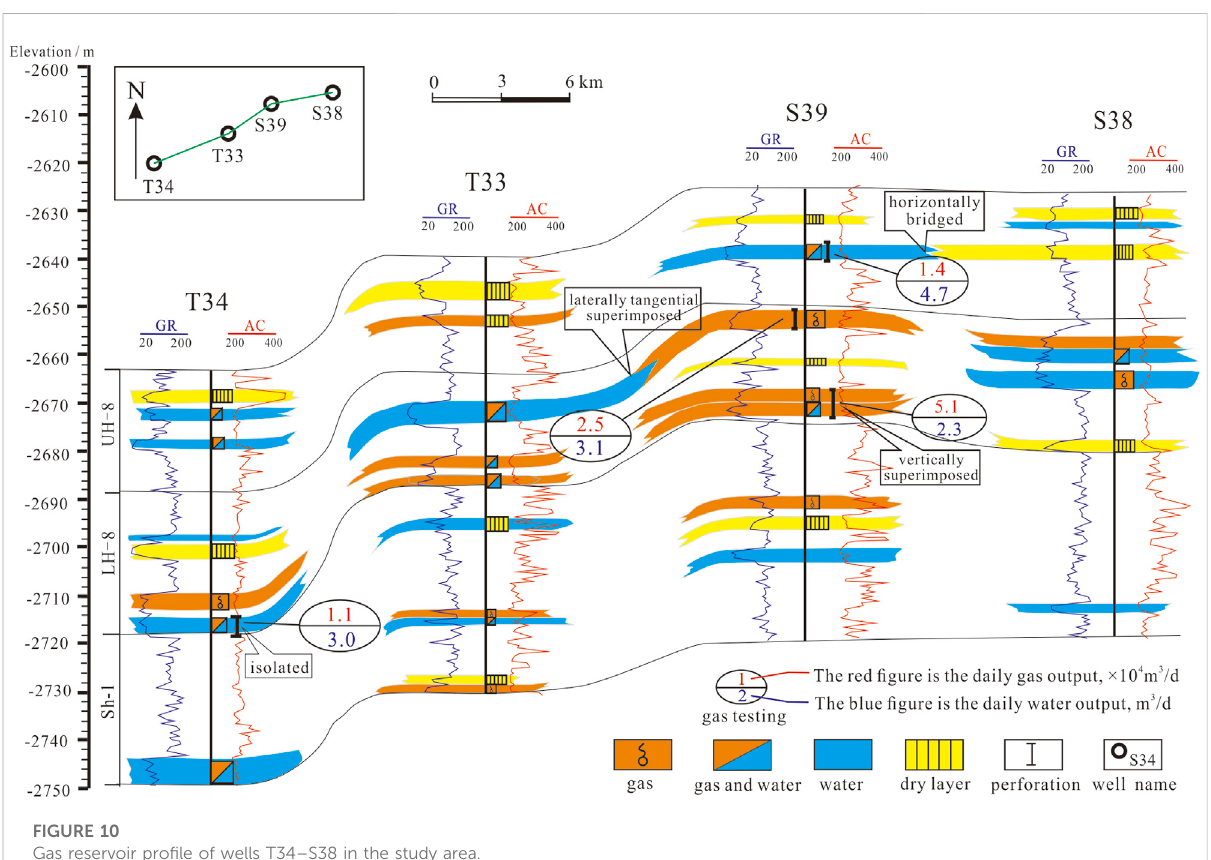
FIGURE 10 Gas reservoir pro fi le of wells T34 – S38 in the study